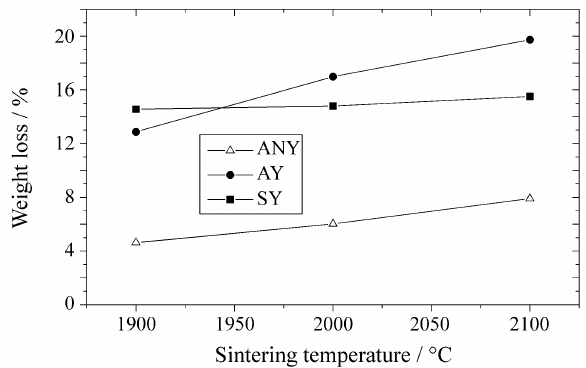
Figure 2. Weight loss of the samples vs. sintering temperature.